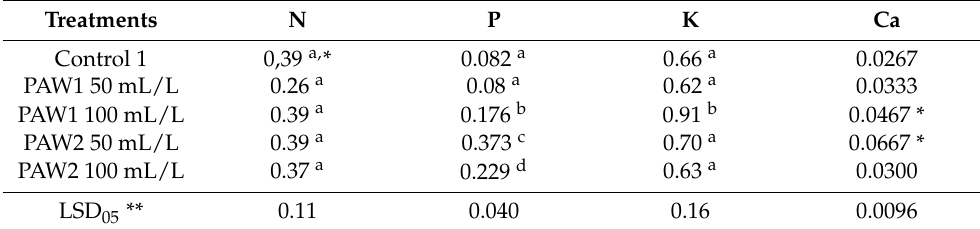
Table 3. Effect of PAW on the primary nutrient contents of apple fruits. Treatments